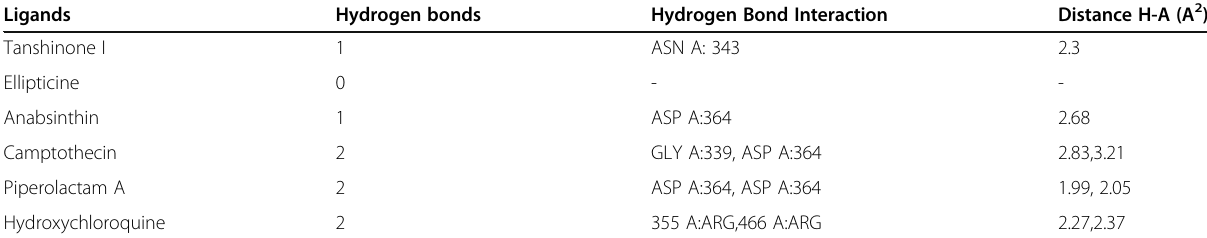
Table 2 HB Interaction with the Screened Ligands